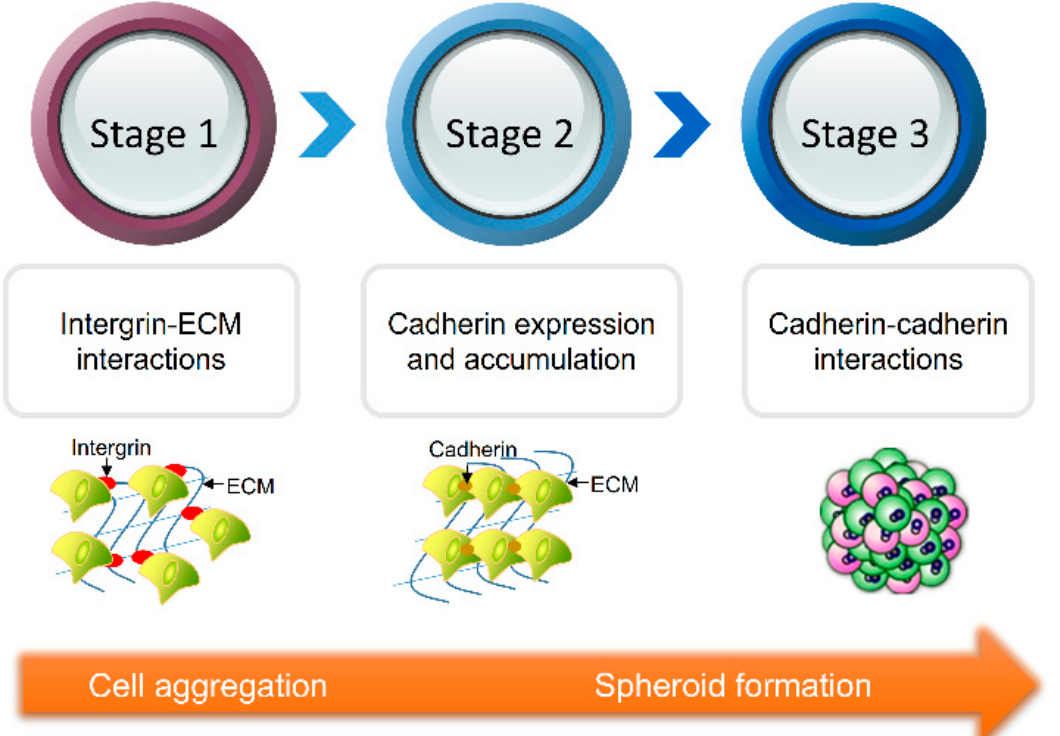
Figure 1. The multicellular spheroid (MCS) formation process is divided into three stages. In the first stage, the extracellular matrix (ECM) acts as a long link head, and the scattered single cells form loose aggregates under the action of integrins. In the second stage, the epithelial cadherin accumulates, and the aggregates enter the delayed phase of suspension of compaction. In the third stage, the loose cell aggregates form dense spheroids under the strong hemophilic interaction of epithelial